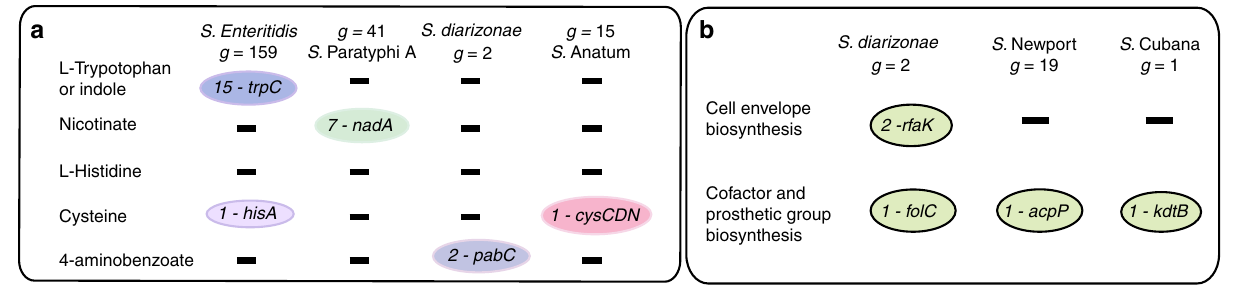
Fig. 5 GEM-predicted auxotrophies and potential alternative metabolic pathways Serovars of S. enterica spp . enterica are highlighted: S . Paratyphi A, S . Anatum, S . Newport, and S . Cubana. a Nutrient auxotrophies are listed across serovars with the name of the missing gene that was found to cause the auxotrophy and the number of GEMs of that serovar affected. b Missing essential genes whose functions are likely carried out by an alternative unknown pathway in a serovar. g represents the total number of strains representing a serovar. For example there are 159 Enteritidis strains that were analyzed for auxotrophies. See Supplementary Fig. 7 for a multiple sequence alignment of the